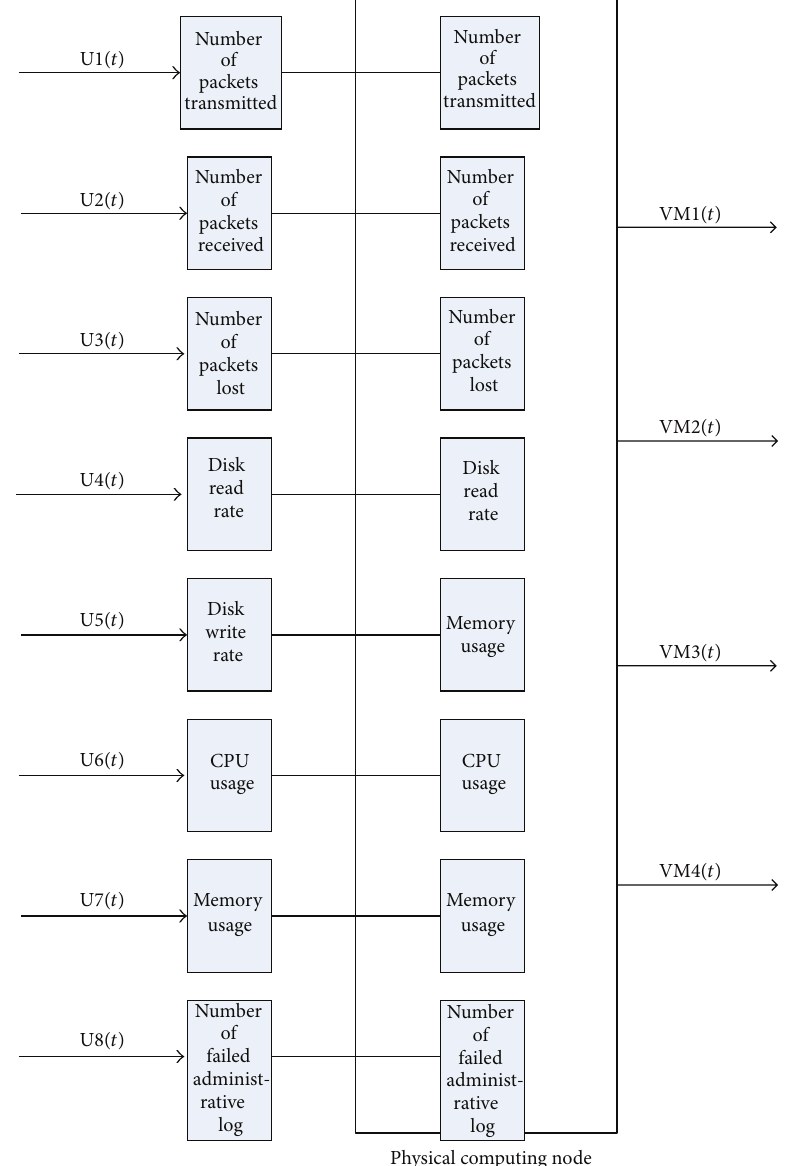
Figure 2: Description of physical computing nodes in the view of generalized predictive